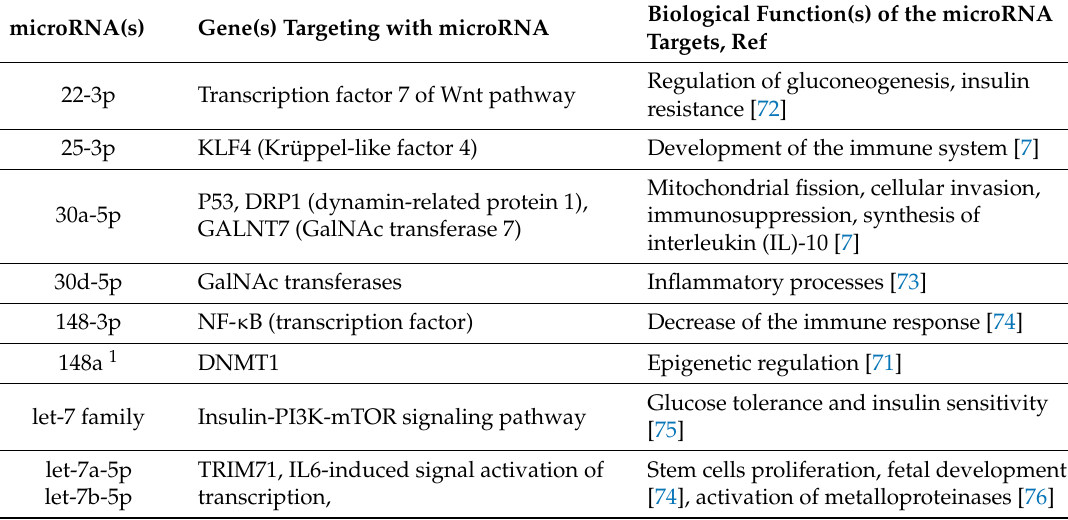
Table 3. Genes regulated by a highly abundant microRNA of milk